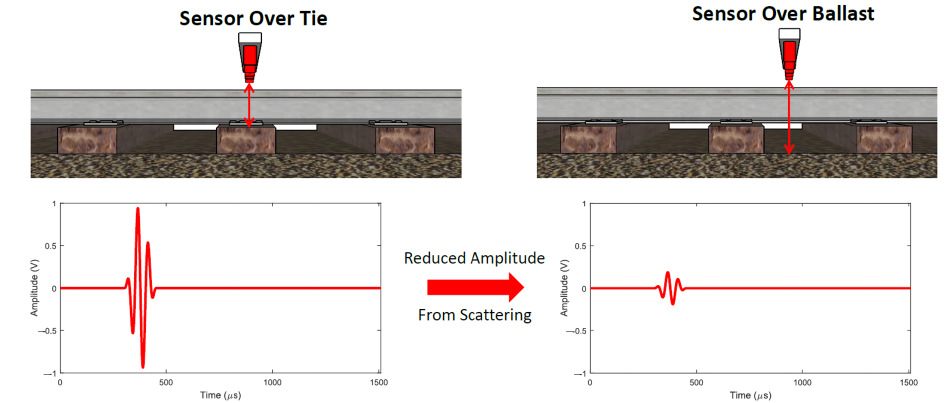
Figure 4. Difference in reflected waveform amplitude from the tie and